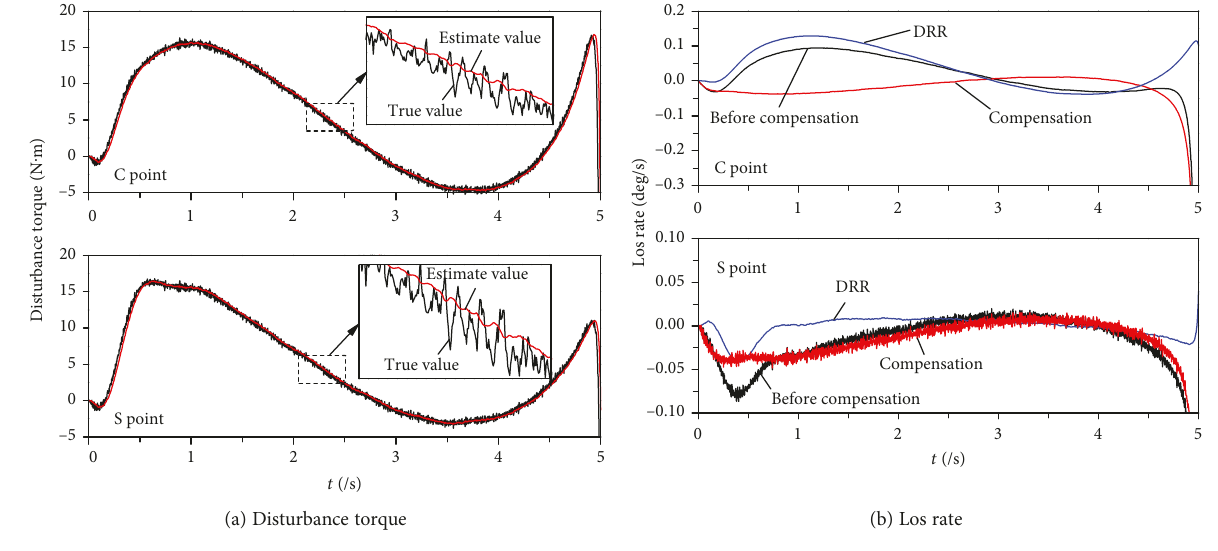
Figure 17: Damping